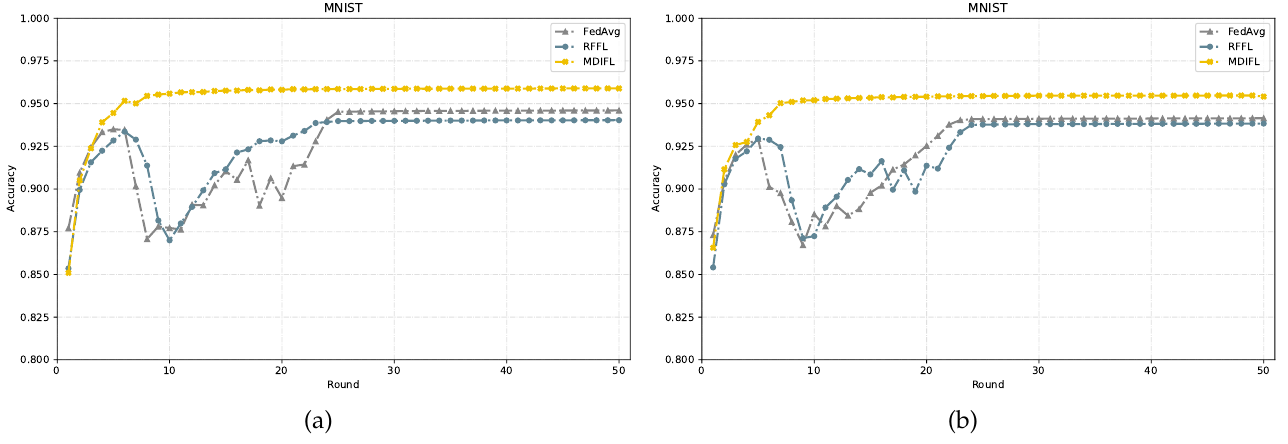
Figure 6. Accuracy comparison of MDIFL, FedAvg and RFFL. ( a ) Ten honest participants and 110% of S_P under UNI split MNIST. ( b ) Ten honest participants and 110% of S_P under POW split MNIST.